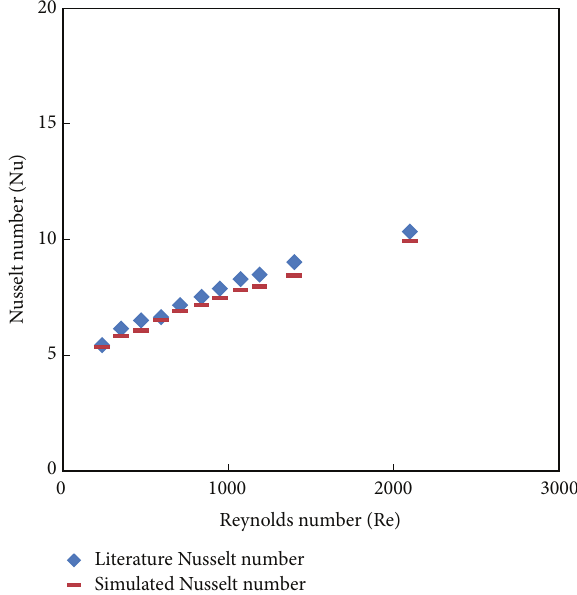
Figure 4: Plain tube simulated Nusselt number versus the literature data.